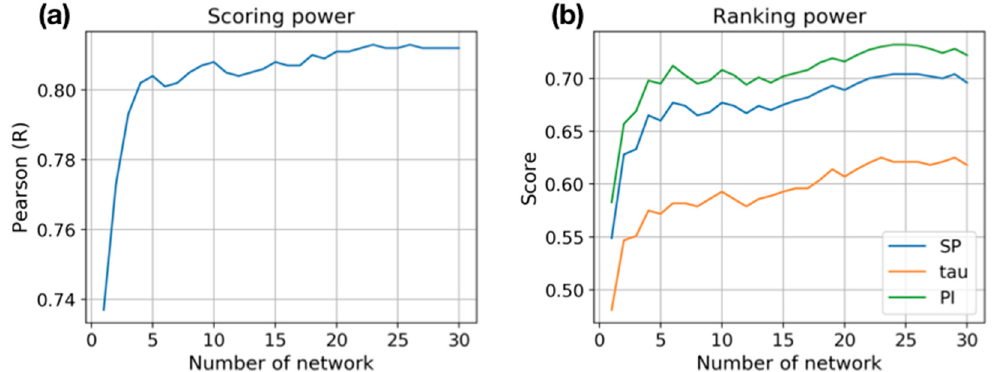
Figure 2. The change of prediction quality by the size of the ensemble of networks. ( a ) Scoring power is measured by the Pearson correlation coefficient between the experimental and predicted binding affinities. ( b ) Ranking power is measured by three rank correlation coefficients, Spearman (SP), Kendall tau (tau), and predictive Index (PI).